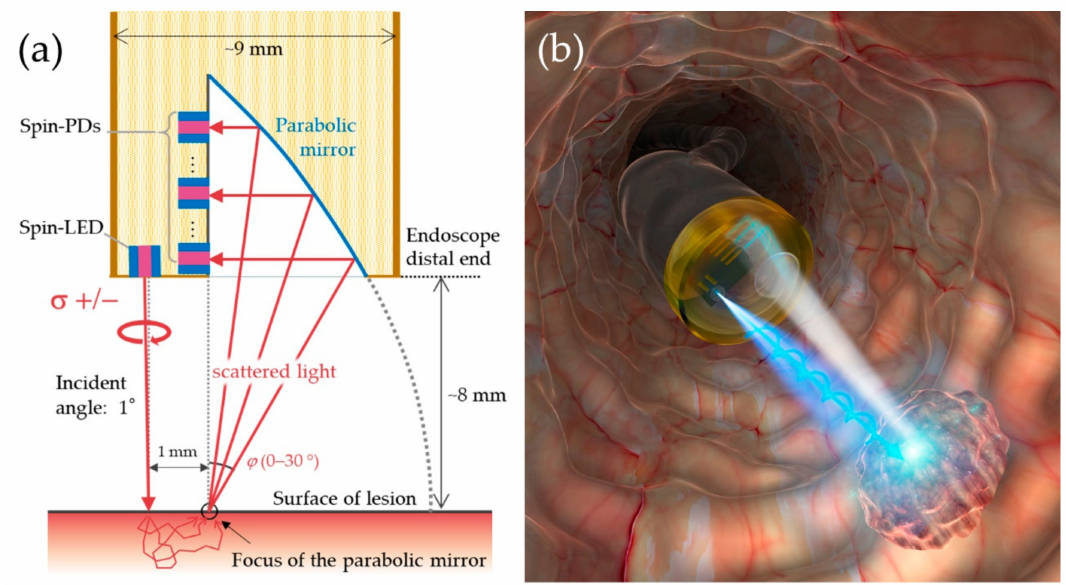
Figure 12. ( a ) The schematic cross-sectional design of an endoscope probe structure consisting of one spin-LED, an array of spin-PDs, and a parabolic mirror in the ideal case that the focus of the mirror is at the surface of the lesion. The scattered light beams from the detection point (the focal point of the mirror) with different angles are reflected by the mirror and detected by respective spin-PDs. Reproduced with permission from [148,149]. ( b ) Schematic illustration of in vivo cancer diagnosis with the designed CPL device assembly attached to the tip of an endoscope. Reproduced with permission from